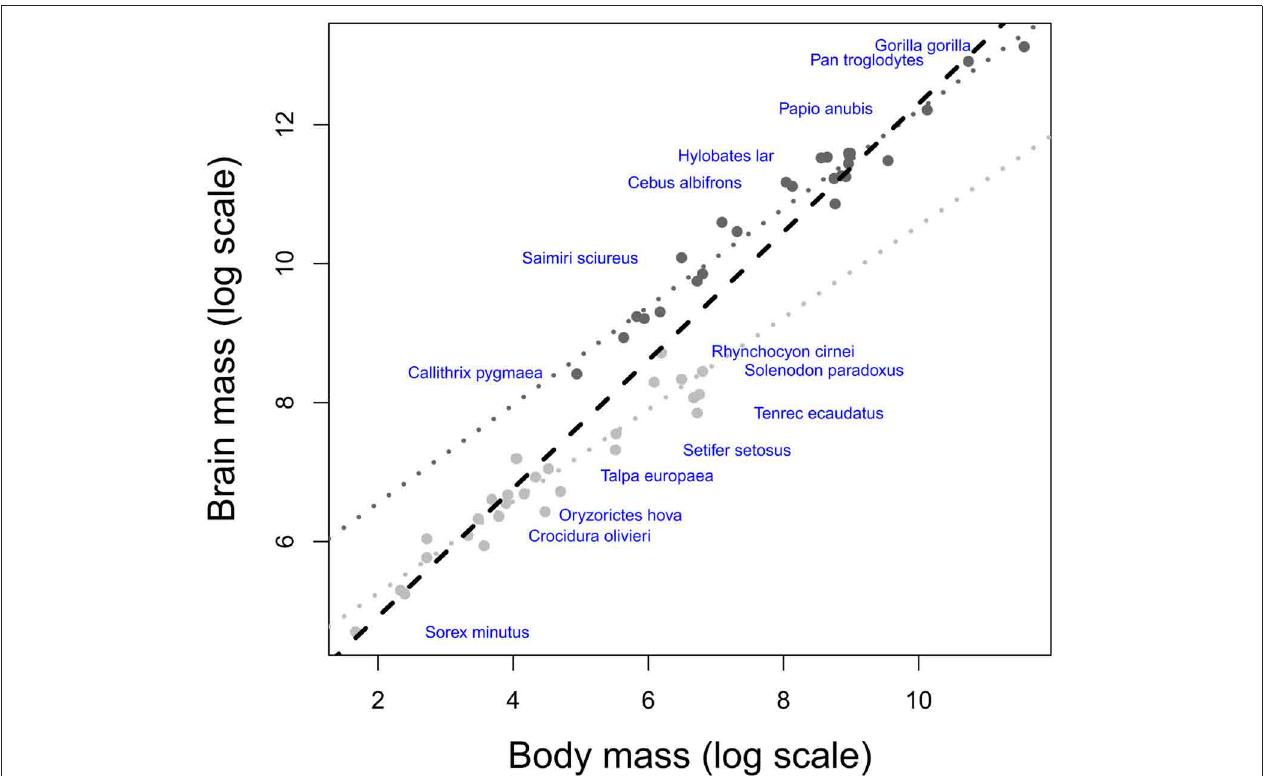
FIGURE 1 | Scatter plotof brain weightonto bodyweight(log scale) in insectivores(lightgray) and simians(darkgray). Humanshave been excludedfrom theanalysis dueto their large encephalizationquotient(Rilling, 2006;butseeHerculano-HouzelandKaas,2011).Thedottedlinesrepresentthe